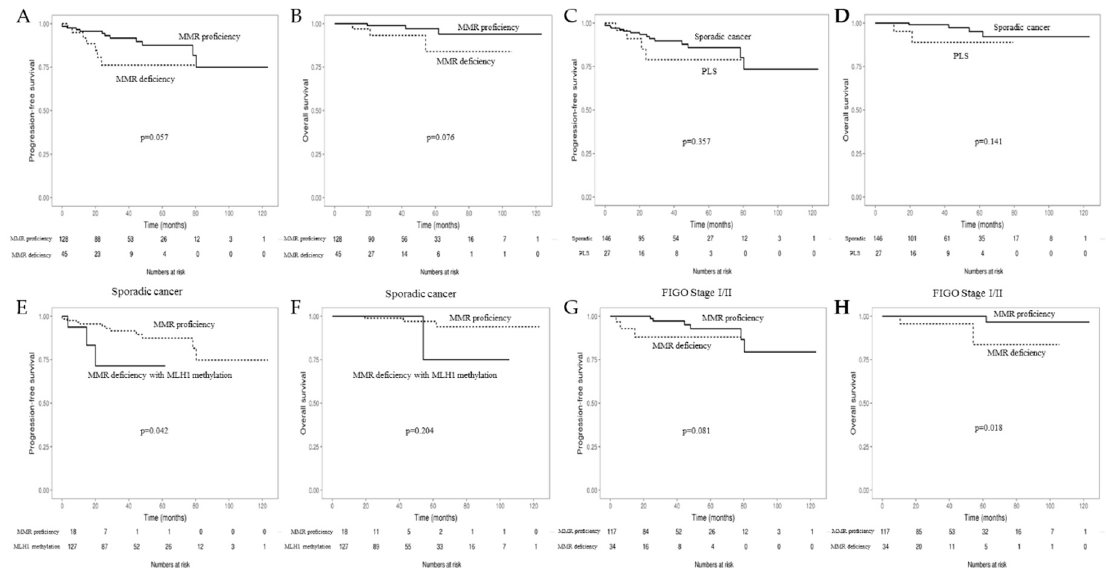
Figure 3. Kaplan–Meier curves for progression-free survival (PFS) and overall survival (OS) according to the DNA mismatch repair (MMR) immunohistochemistry (IHC) status and MLH1 promotor methylation status for endometrial cancer. PFS ( A ) and OS ( B ) in the MMR-deficient vs the MMR-proficient group. PFS ( C ) and OS ( D ) in the sporadic cancer vs the PLS group. Comparison of PFS ( E ) and OS ( F ) in the sporadic cancer group between those with MMR deficiency with MLH1 methylation and those with MMR proficiency. PFS ( G ) and OS ( H ) of the MMR-deficient vs the MMR proficient group in the patients with FIGO stages I–II.